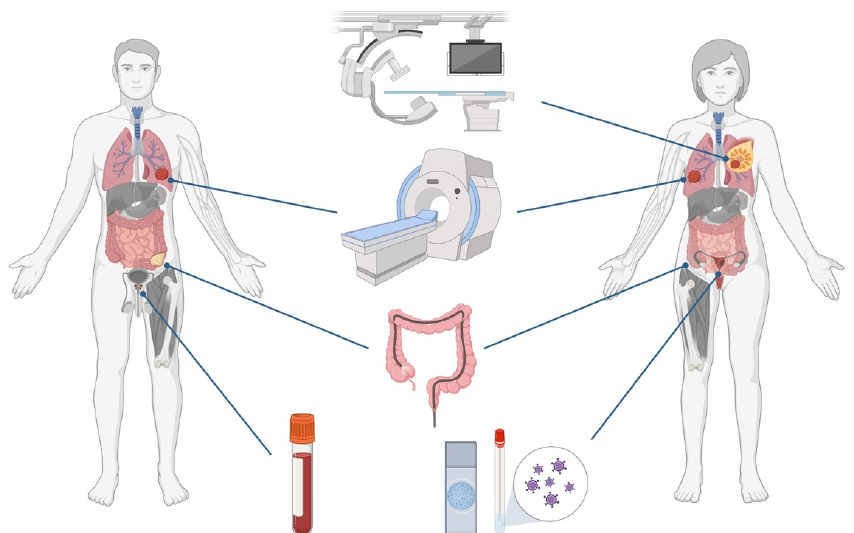
Figure 1. Currently available cancer screening options: mammography for breast cancer; low-dose CT for lung cancer; colonoscopy for colorectal cancer; cytology and HPV testing for cervical cancer; serum PSA testing for prostate cancer. Colored organs represent those with available screening; grey organs represent those without any current screening option (not all cancer types are represented). Created with Biorender.com.